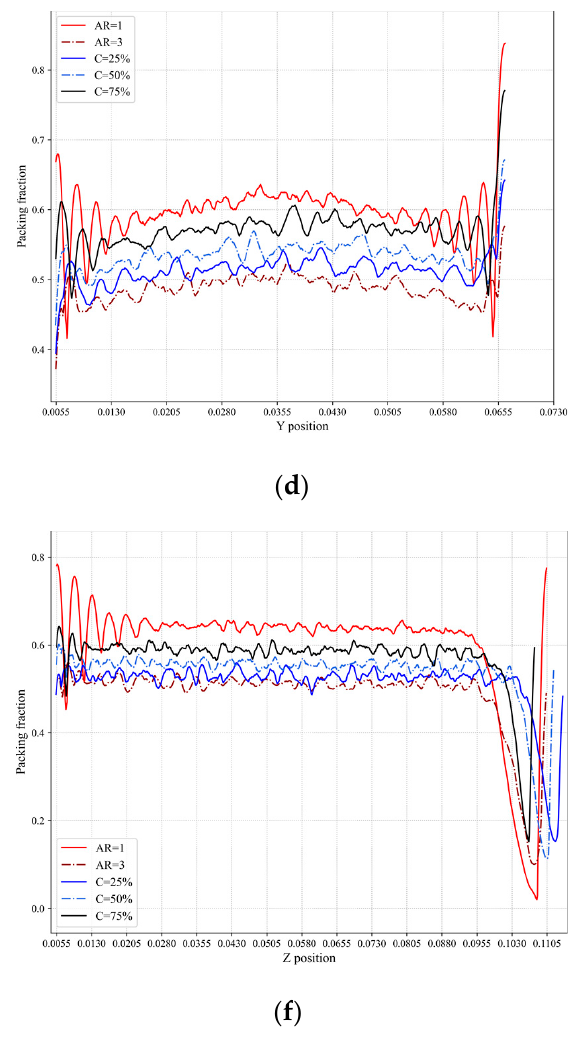
Figure 7. Packing fraction along x,y,z direction for ( a , c , e ) binary mixtures of AR = 1 and AR = 2, monodisperse AR = 1 and monodisperse AR = 2, and ( b , d , f ) binary mixtures of AR = 1 and AR = 3, monodisperse AR = 1 and monodisperse AR = 3.